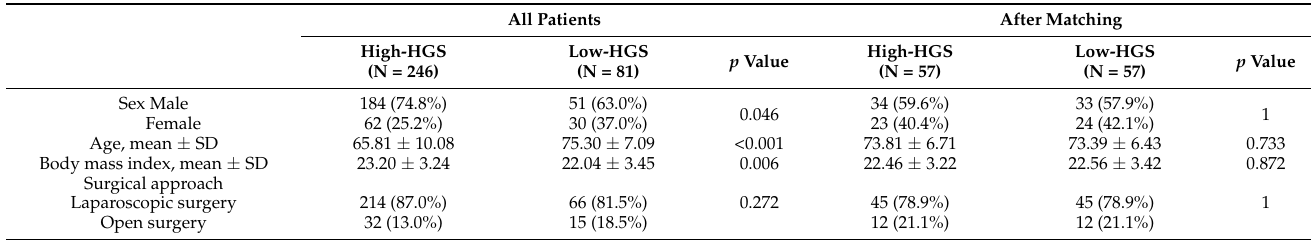
Table 2. Patient characteristics before and after propensity score matching. All